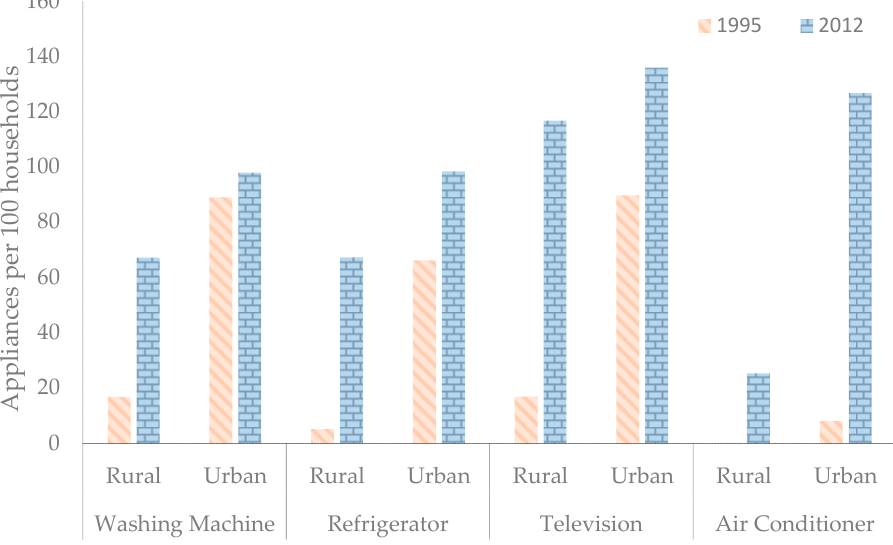
Figure 1. Ownership of appliances per 100 households in China’s rural and urban areas. Data source: China Statistical Yearbook 1996 [4] and China Statistical Yearbook 2013 [4].